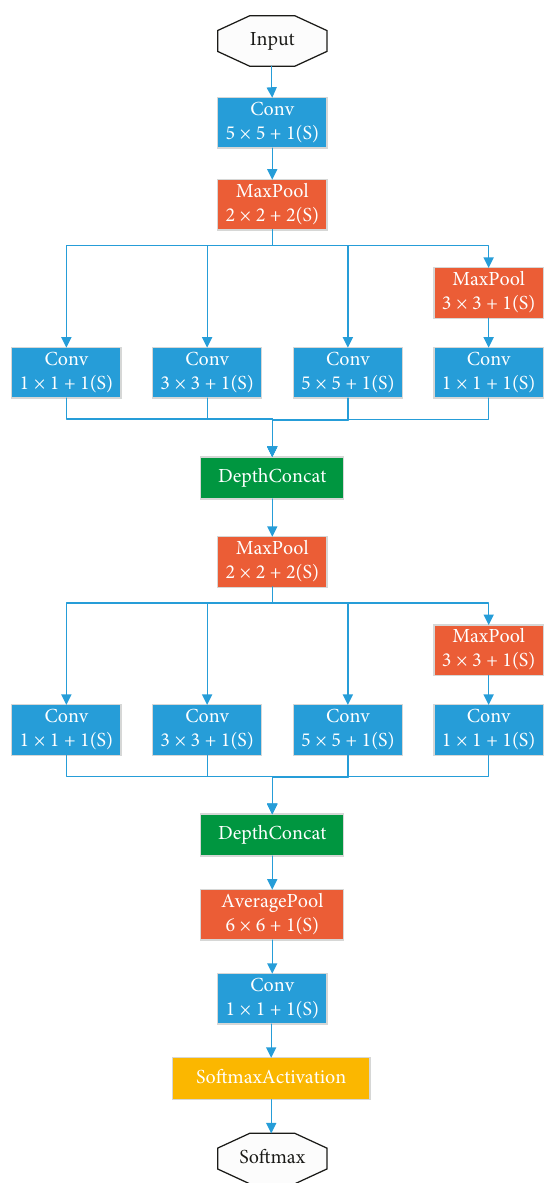
Figure 6: Overall architecture of the proposed